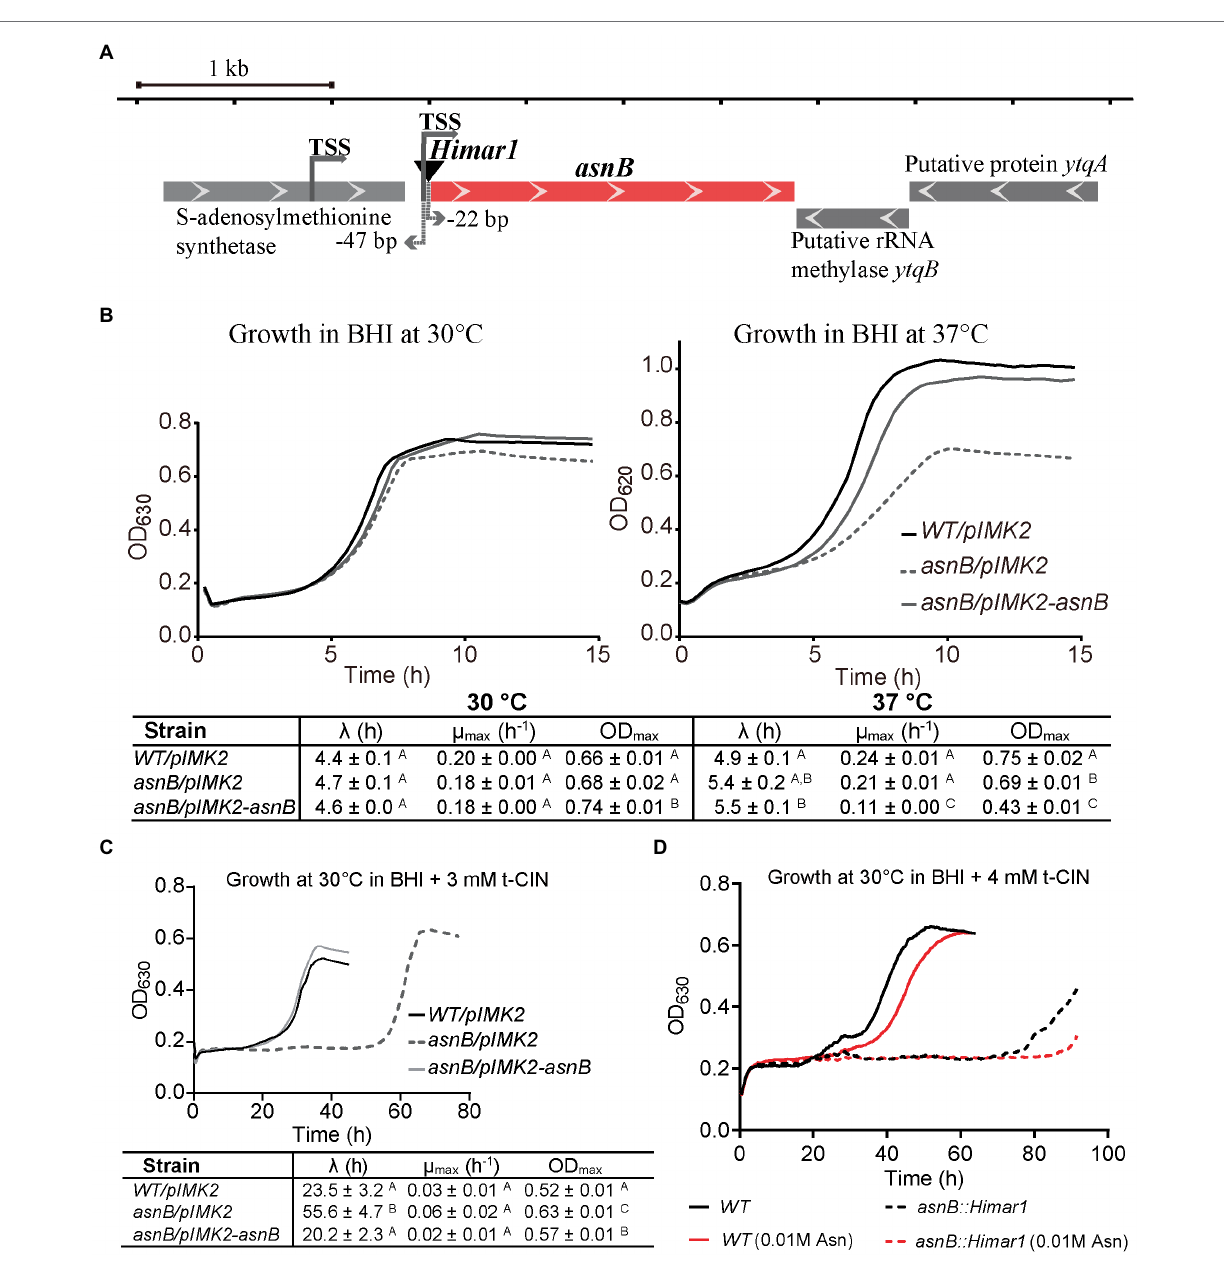
FIGURE 1 | Characterization of the t -CIN sensitive Listeria monocytogenes asnB mutant. (A) Genomic context of the asnB gene. Gene orientations are indicated by white arrows in the gene boxes. The Himar1 transposon (black inverted triangle) is inserted at − 22 bp of the asnB start codon. Transcription start sites (TSSs; Wurtzel et al., 2012) of asnB are indicated with gray arrows. (B) Growth curves and growth parameters of WT/pIMK2 , asnB/pIMK2 , and asnB/pIMK2-asnB in BHI broth at 30 ° C (left) and 37 ° C (right). (C) Growth curves and growth parameters of the same strains in BHI broth with 3 mM t-CIN at 30 ° C. (D) Growth curves of the asnB::Himar1 mutant compared to the WT strain in BHI broth with 4 mM t-CIN with and without addition of Asn. The growth parameters [lag phase ( λ ), maximum growth rate ( μ max), and maximum optical density (ODmax)] represent mean ± SD; n = 3. Values of different strains followed by a common letter are not different at the 5% level of